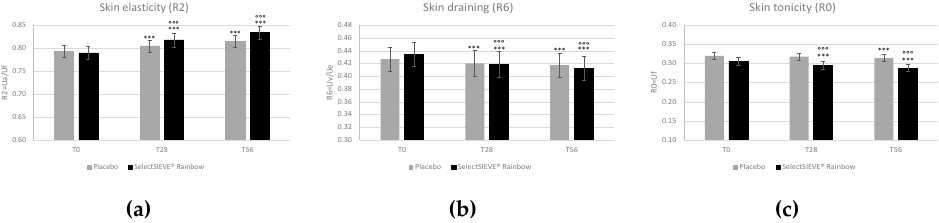
Figure 4. ( a ) Skin elasticity (R2): R2 values are directly proportional to the degree of skin elasticity: An increase of this parameter is indicative of an improvement of skin elasticity. ( b ) Skin draining (R6): R6 values are inversely proportional to the degree of skin viscoelasticity: A decrease of this parameter is indicative of an improvement of skin distensibility. ( c ) Skin tonicity (R0): R0 values are inversely proportional to the degree of skin firmness: A reduction of this parameter is indicative of an improvement of skin firmness. The graphs show the mean variation obtained for each parameter. *** Indicates a statistically significant change compared to T0, p < 0.001. °°° Indicates a statistically significant change compared to placebo, p < 0.001. Data are expressed as means ± SEM. Thermographic evaluations of the skin microcirculation revealed that the active treatment determined an improvement of the cellulite thermographic grade in 57% of the subjects at T28 and in 60% of the subjects at the end of the study, while in the placebo-treated group, the improvement percentages were very low (Figure 5a). Contact thermography pictures showed that from an initial stage of 6 (Grade III—severe of the thermographic scale—leopard spots—cold temperature), a slight improvement was noticed at T28 (bigger warm areas) and a moderate improvement at T56 (smaller spots—higher temperature) (Figure 5b).